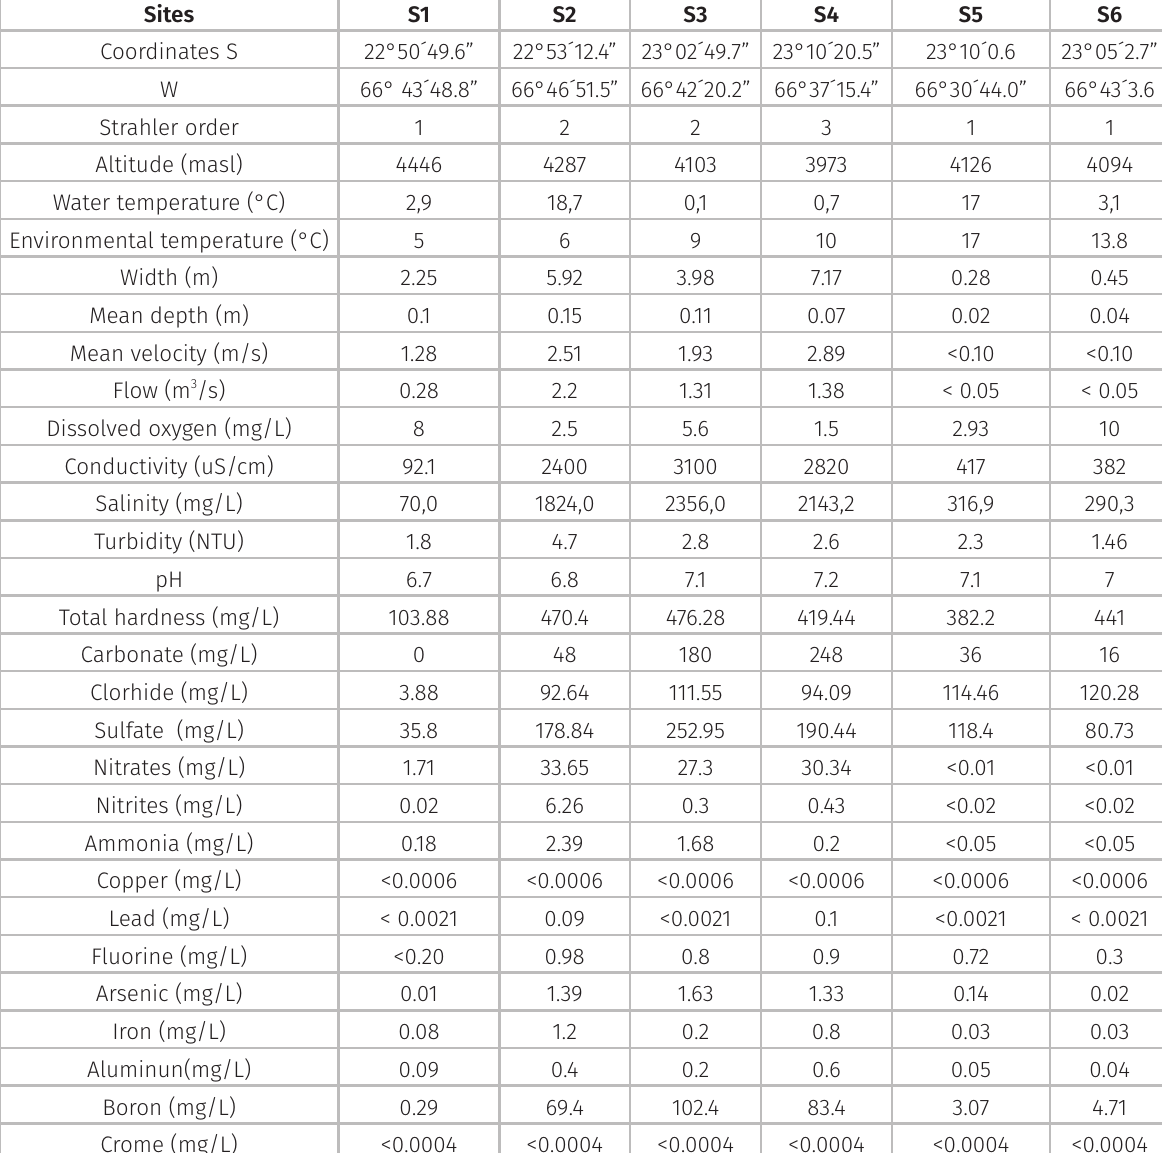
Table I. Values of the physicochemical variables registered at the sampling sites in rivers: Rosario, Sierra de Tanques, Toro (Salar de Olaroz, Jujuy,